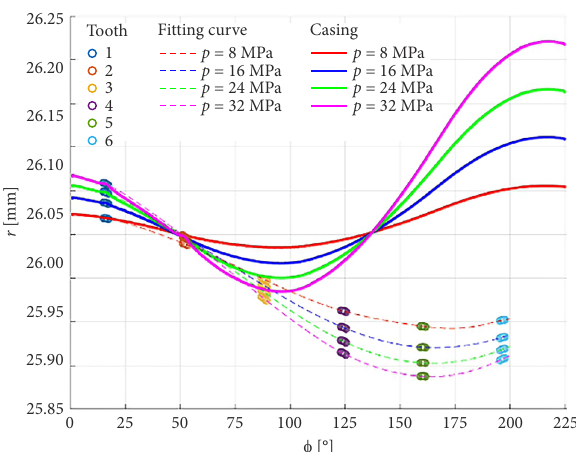
Figure 7. Distances of the tips in the driving wheel and the inner casing surface from the axis of rotation of the gear (unloaded)